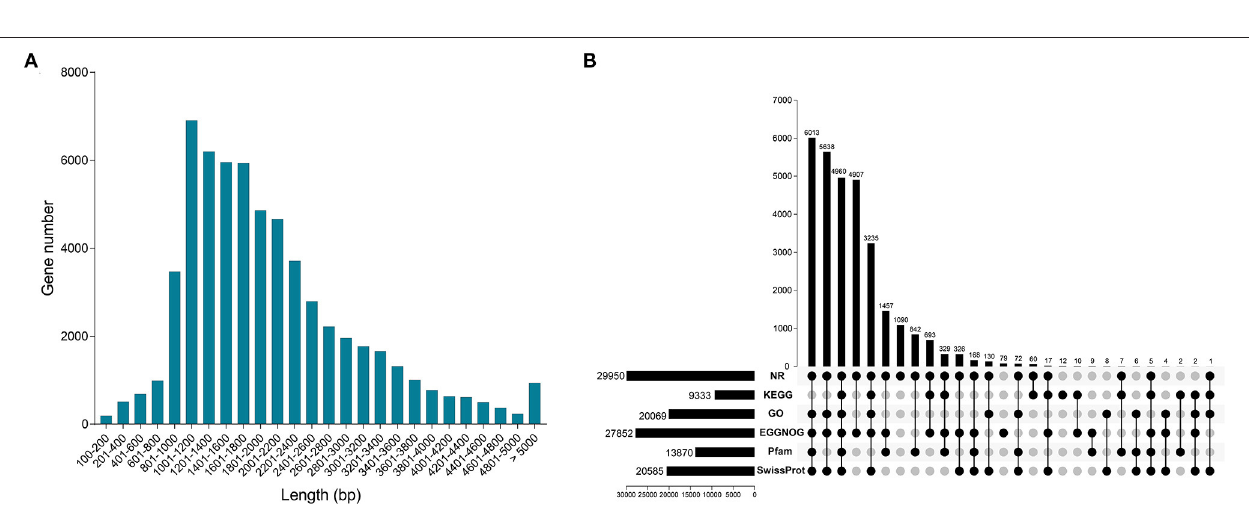
FIGURE 2 | Characterization of full-length transcriptome. (A) The distribution of all gene length. (B) Functional annotation of all genes from NR, KEGG, GO, eggNOG, Pfam and SwissProt databases.